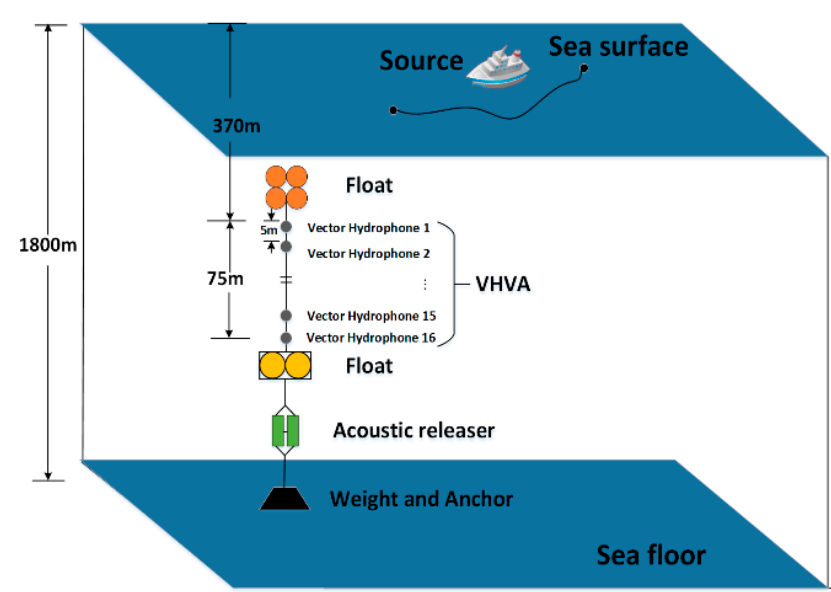
Figure 9. Picture of vector hydrophone.